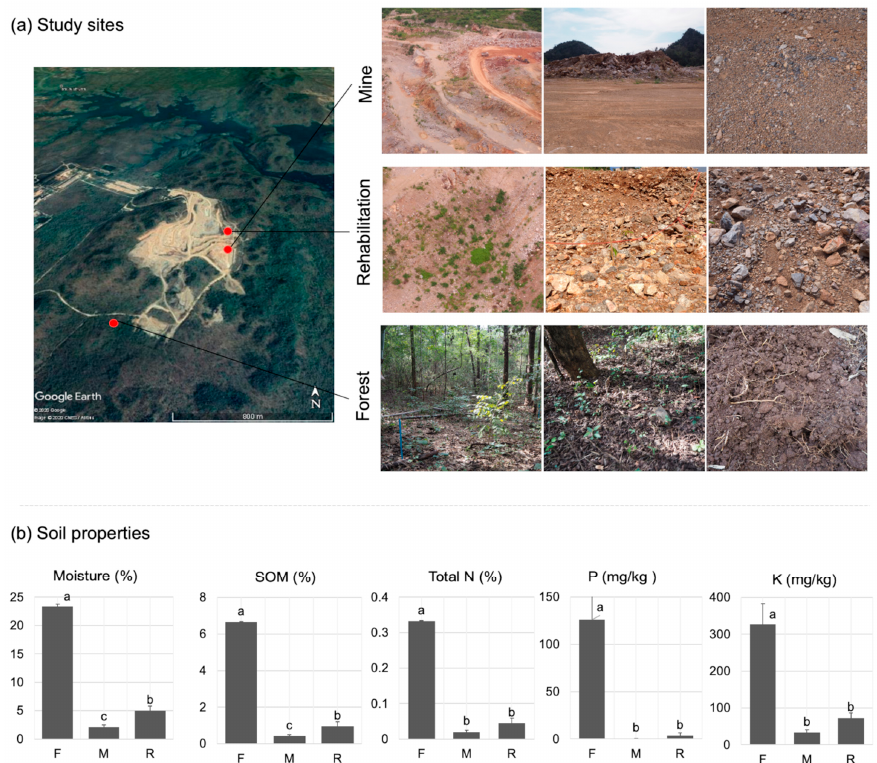
Figure 1. Study sites and soil physicochemical properties. ( a ) Study site locations with an overview of the semi-opencast limestone mine and photos of three study sites including natural forest (F), mining site (M), and rehabilitation plots (R); ( b ) Soil physicochemical properties, including moisture, soil organic matter (SOM), total nitrogen (Total N), phosphorous (P), and potassium (K). Different lowercase letters (a, b and c) indicate significant